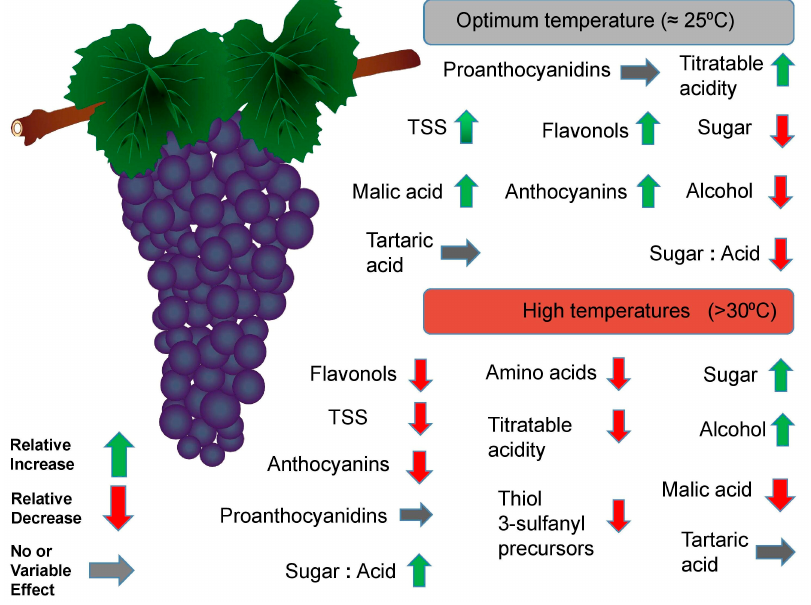
Figure 4. Summary of the effects of high-temperature stress on grape berry metabolism.